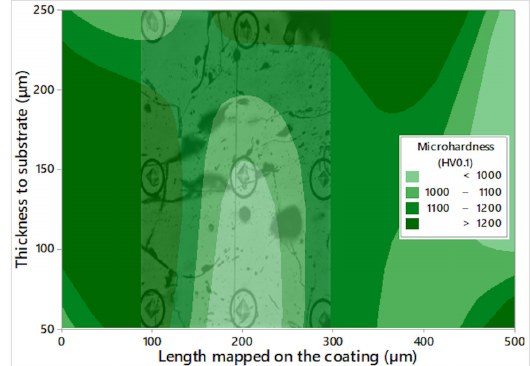
Figure 9. Microhardness mapping of coating